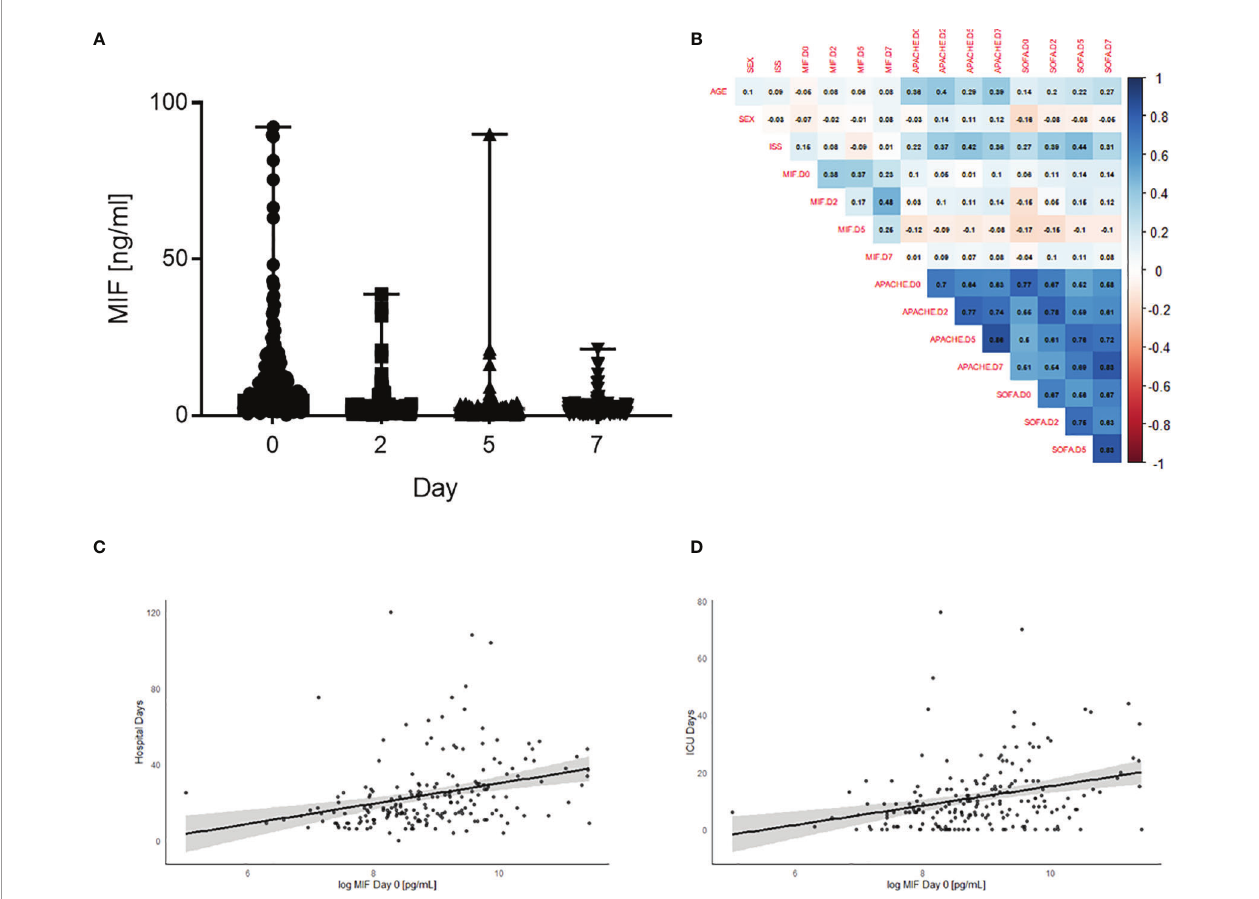
FIGURE 1 | Plasma MIF levels are elevated in polytrauma patients and associated with longer stay in ICU and hospital. (A) Plasma MIF levels in trauma patients (n = 208) at different time points: Day 0 (Emergency room), Day 2, Day 5 and Day 7. Data are expressed as median with range. (B) Heatmap for correlations between MIF levels and baseline characteristics sex, age, SOFA, ISS and APACHE score. Scatter plot for Day 0 MIF levels against (C) hospital stay and (D) intensive care unit (ICU)